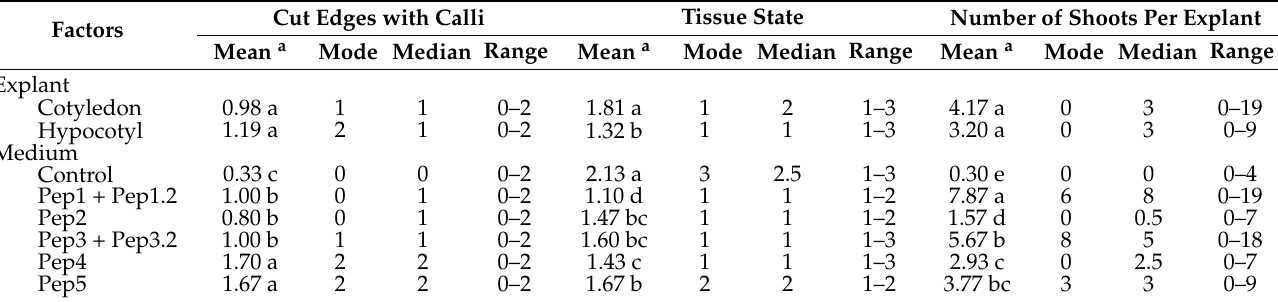
Table 4. Organogenesis of C. baccatum explants. Mean, statistical significance (groups defined with lower-case letters, p < 0.05), mode, median and range of the number of cut edges with calli ( n ; after one month), the tissue state (measured on a 1–3 scale—1 = green tissue, 2 = dull greyish brown tissue; 3 = dead tissue—after two months) and the number of shoots per explant (n; after two months) depending on the type of explant (cotyledon and hypocotyl) and the medium used for regeneration. An experimental session, with three replicates for each combination of factors and five explants per plate, was carried